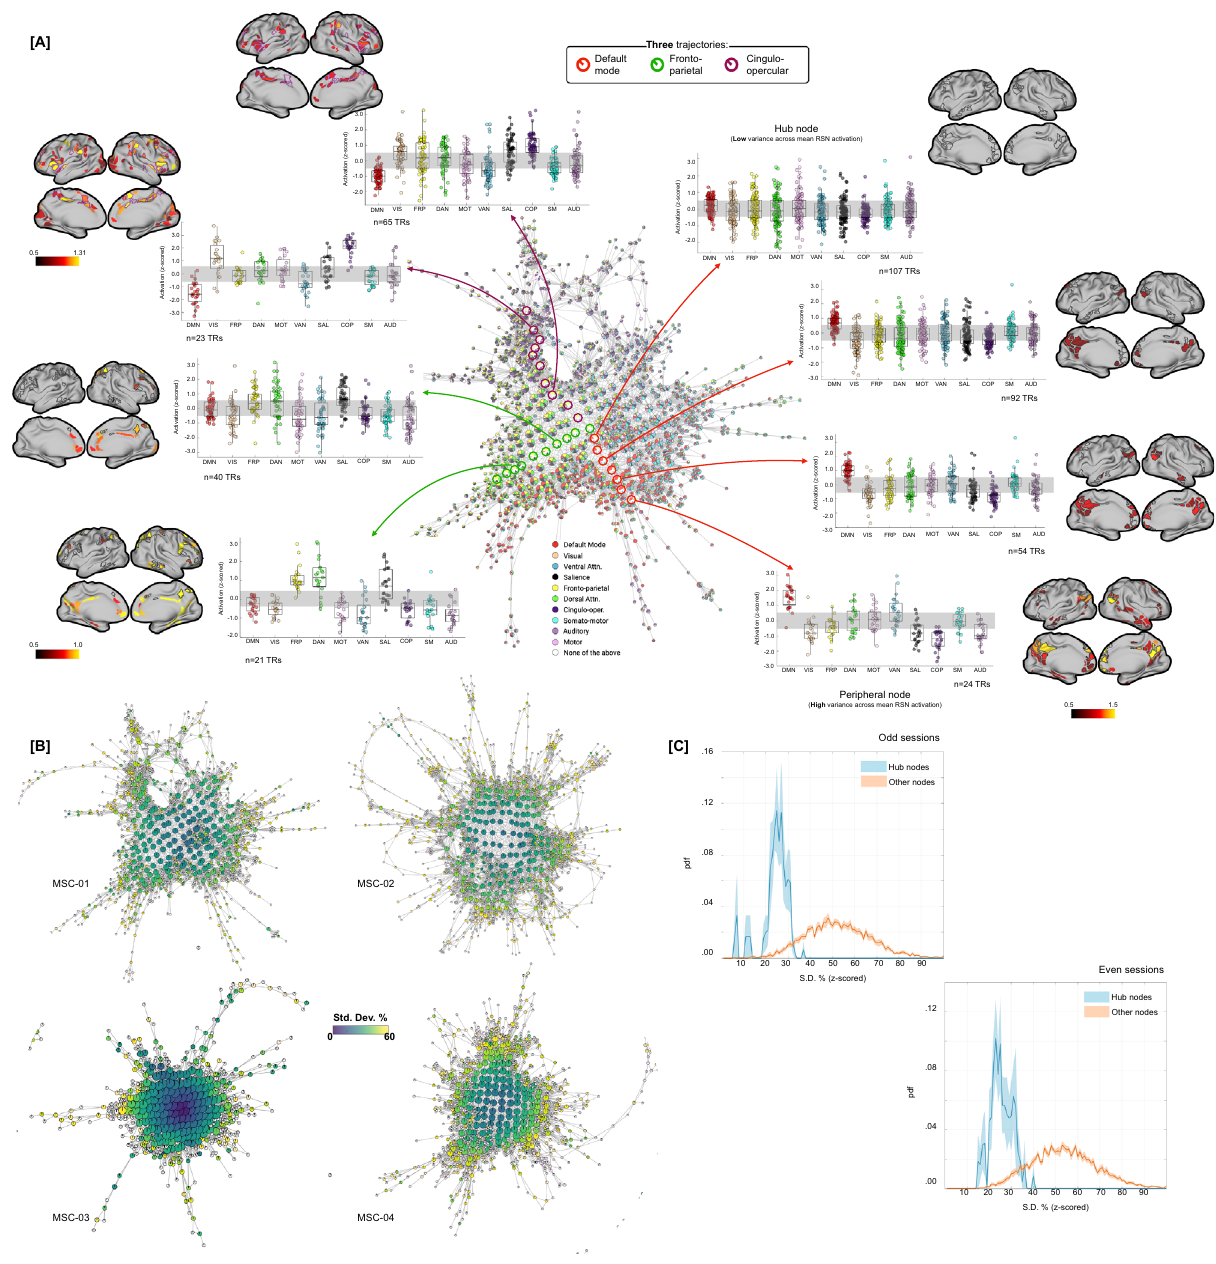
Fig. 5 | Annotating the traversal on Mapper-generated landscape using a variance-based approach revealed a dynamical topographic gradient . A Depicting traversal on the Mapper-generated landscape from peripheral (RSN- dominated) nodes towards centrally located hubs. Three putative trajectories are highlighted on the Mapper graph, corresponding to three dominating RSNs for MSC-01 participant. For all three trajectories, activation across RSNs (as box plots) andmeanwhole-brainactivity(oncorticalsurfaces)isshownformultiplenodes.As evident, peripheral nodes are dominated by activation in one of the RSNs and traversal towards the hubs resultin reduced RSN activity. In each boxplot, the box denotesinterquartilerange(IQR),thehorizontalbarindicatingthemedian,andthe whiskers include points that are within 1.5×IQR of upper and lower bounds of the IQR (25th and 75th percentiles). B Annotating Mapper-generated graphs using